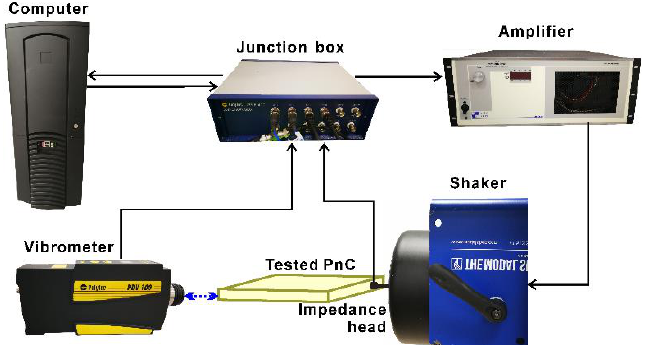
Figure 7. Illustration of the full experimental system. PnC: phononic